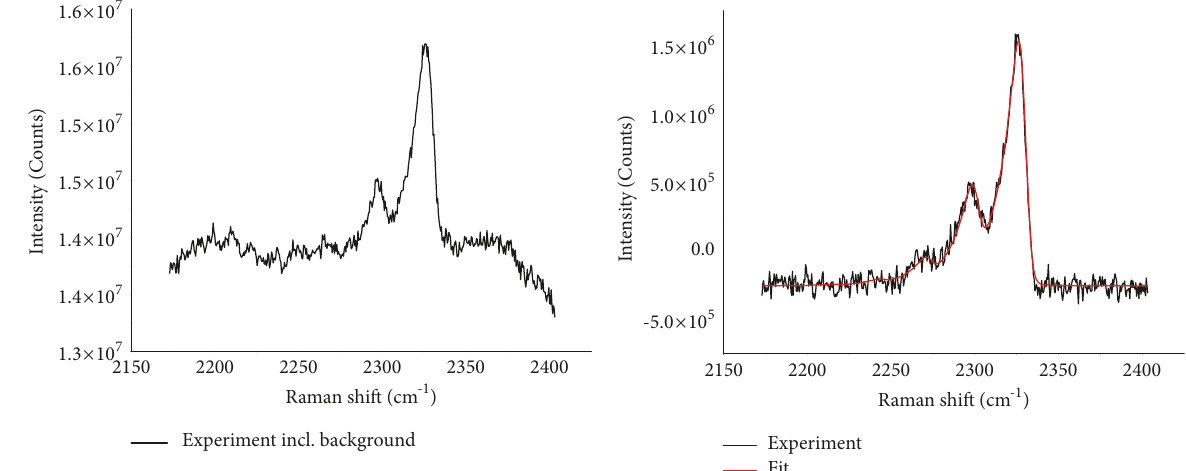
Figure 1: Spontaneous Raman spectrum of nitrogen in a rich ( 𝜙 = 2.1) ethylene flame before (left) and after subtracting background (right) at HAB 5 mm for an exit velocity of 10 cm/s. Fitting yields a temperature of 1775